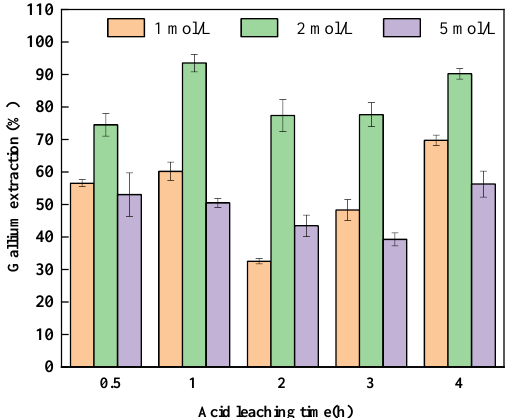
Figure 9. Influence of acid leaching time and acid concentration on gallium extraction (the NaF-CFA mass ratio of 0.75:1, roasting temperature of 800 °C, roasting time of 10 min, leaching temperature of 120 °C, leaching time of 1 h, and HNO 3 concentration of 2 mol/L).